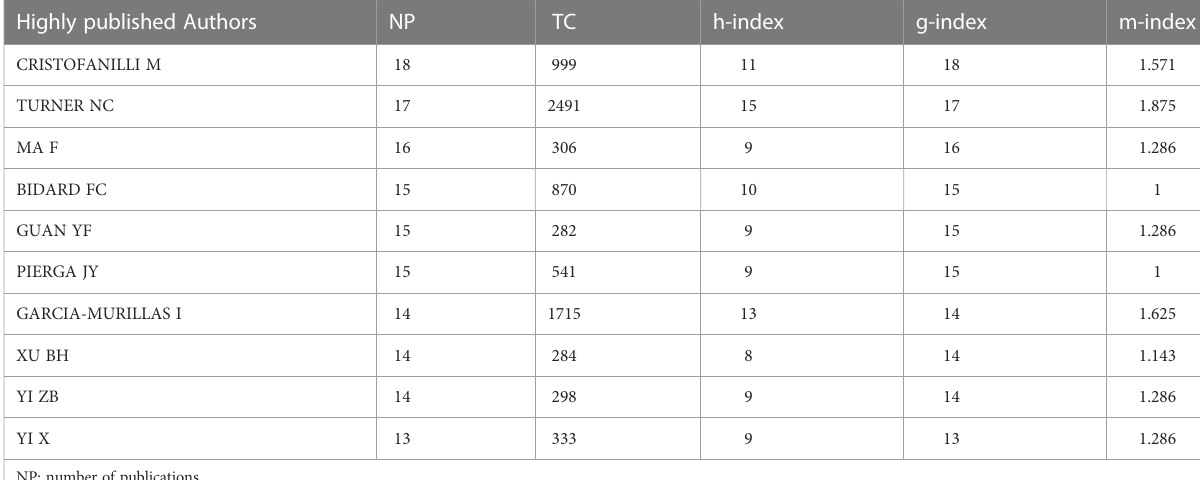
TABLE 3 The top 10 with most published authors in this fi